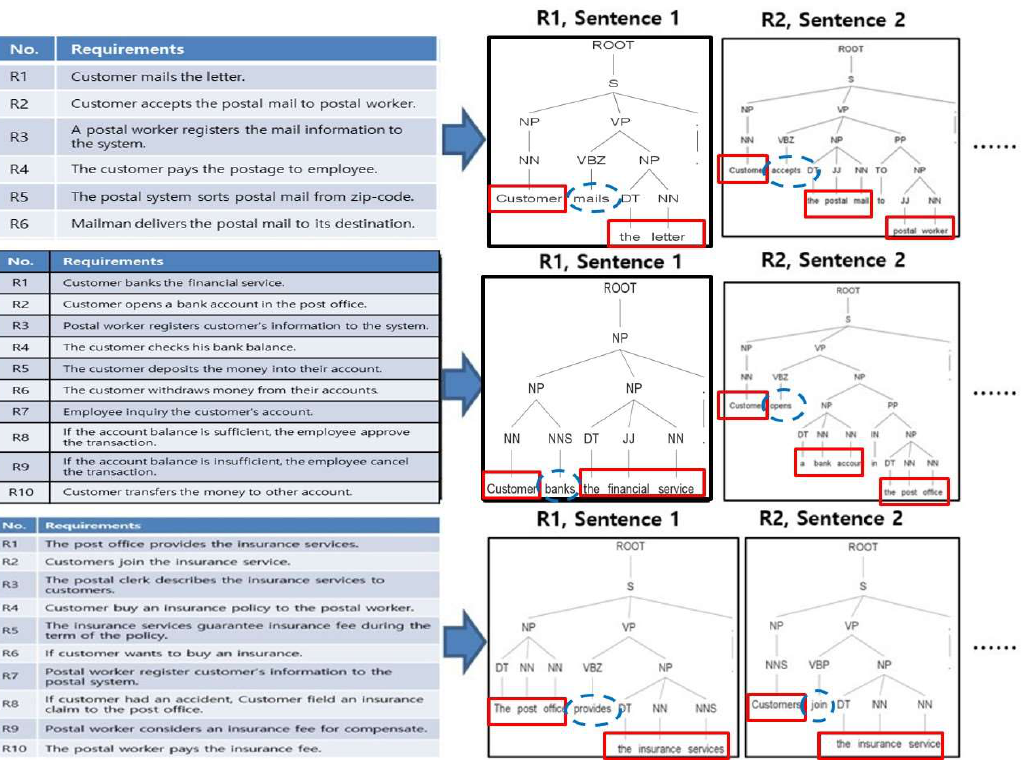
Figure 7. Sentence analysis.